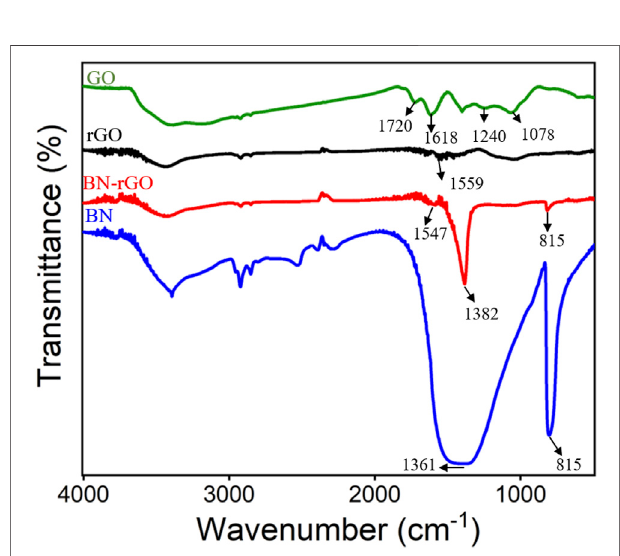
FIGURE 2 | FT-IR spectra of GO, rGO, BN, and BN-rGO.